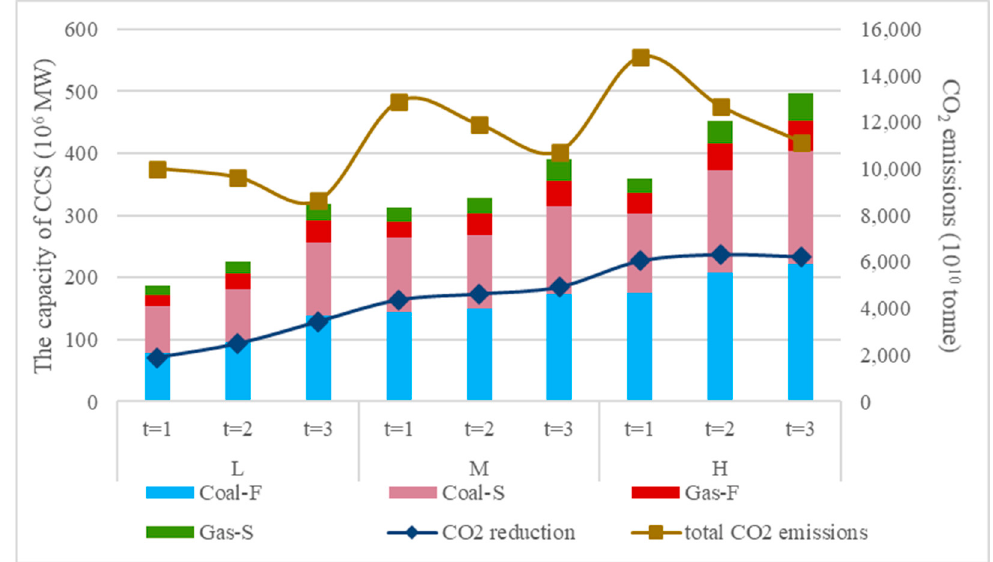
Figure 8. The installation level of CCS devices and CO 2 emissions (-F denotes the flexible water policy scenario, while -S denotes the strict water policy scenario).